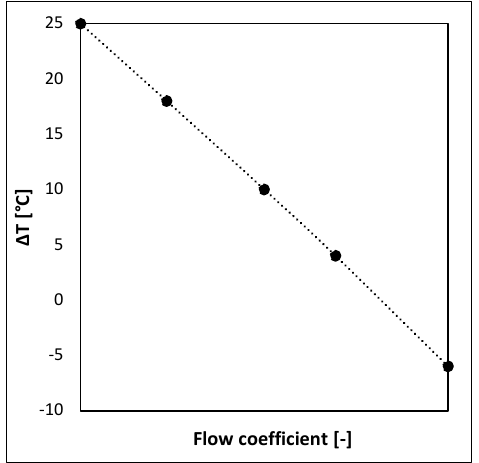
Figure 8. Difference in temperature between calculated data within the blade channel and measure- ments downstream of the blade. Flow coefficient values are not shown for confidentiality reasons.